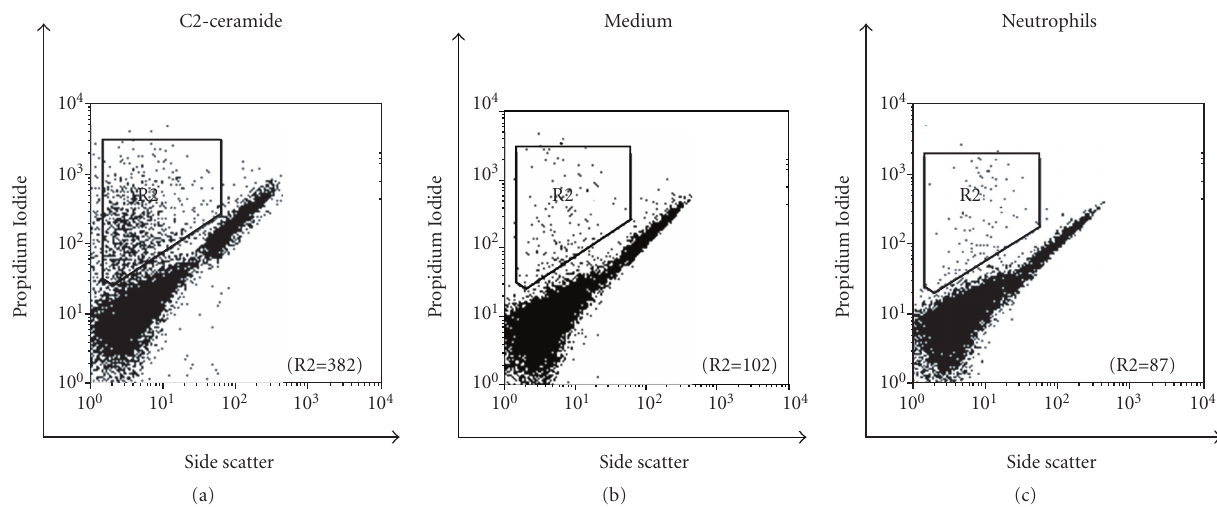
Figure 5: The e ff ects of neutrophil incubation on RPEs cell death. Human RPEs were incubated with neutrophils, C2 - ceramide (20 μ M; positive control), or medium (negative control) for 3 hours and then stained by Propidium iodide ( PI ) . Cell death was evaluated by flow cytometry using 5000 cells for each experiment. The number of nonviable cells (R2) is indicated for each condition. C2-ceramide induced cell death (7.6%). Cells incubated with neutrophils or medium alone had lower cell death, namely, 1.7% and 2.0% cell death, respectively.